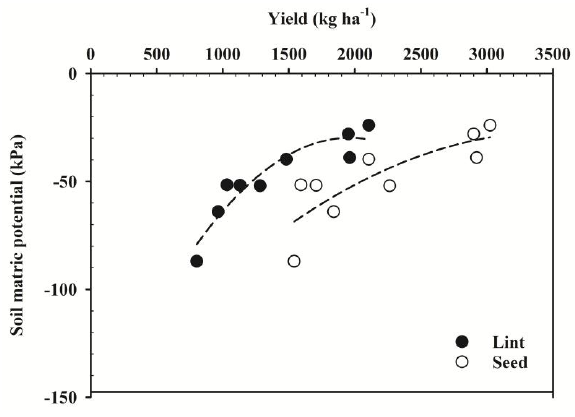
Figure 3. Treatment averages of soil matric potential in ( a ) 2015, ( b ) 2016 and ( c ) 2017.